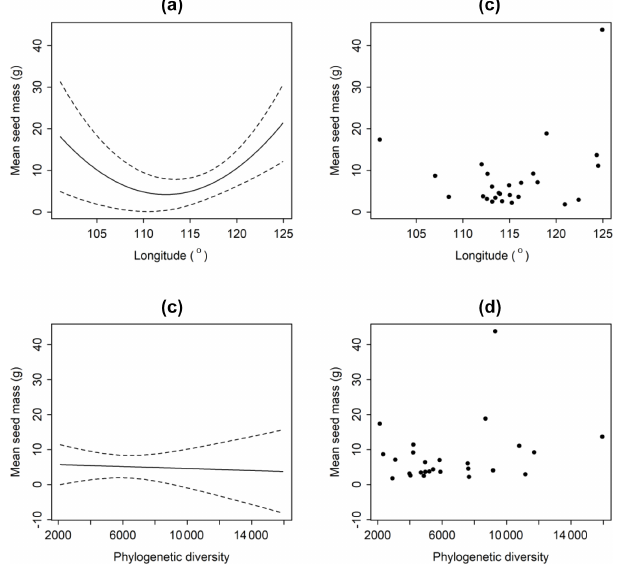
Figure 3. Relationships between average seed mass of communities and longitude (a, b) and phylogenetic diversity (c, d) . The average seed mass declines as longitude rises, and it reaches its bottom at around 114 ◦ , after which that it increases. But average seed mass does not have a significant relationship with phylogenetic diversity ( p > 0 . 05).